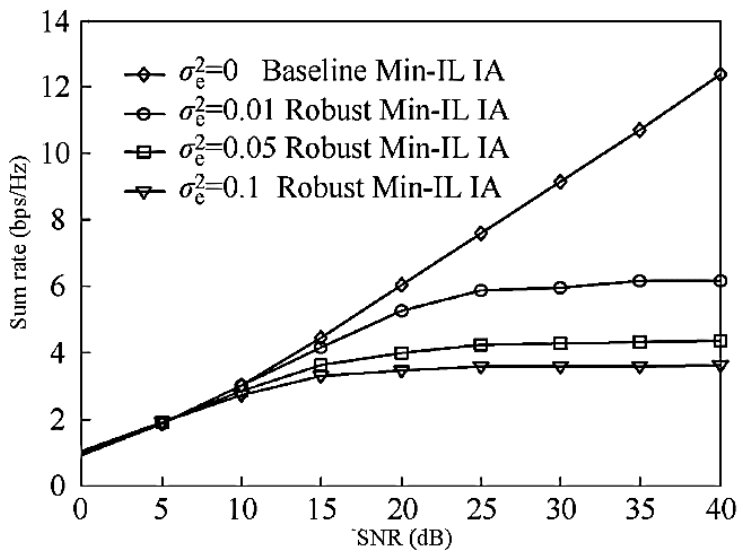
Figure 6. Sum rate comparison under time delay error CSI for multiple cells and users.